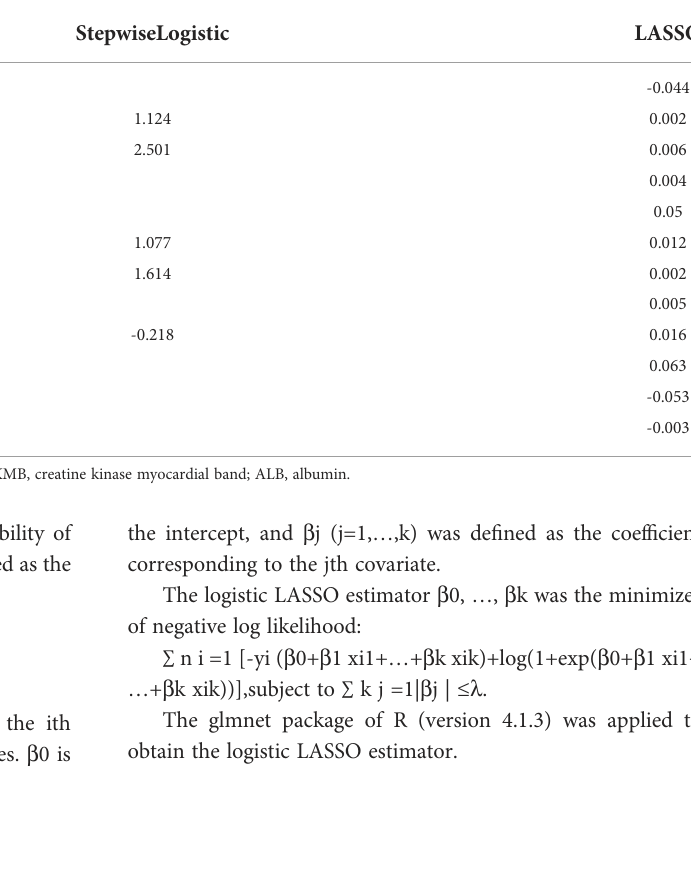
1.124 0.002 2.501